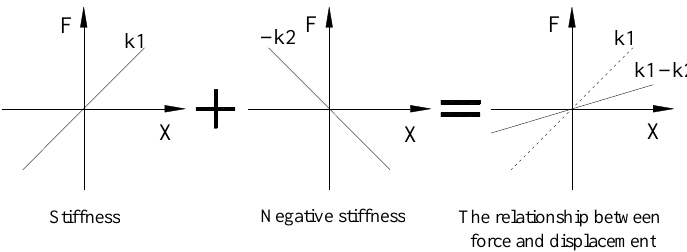
Figure 1. Design principle of negative stiffness hyperboloid damper.